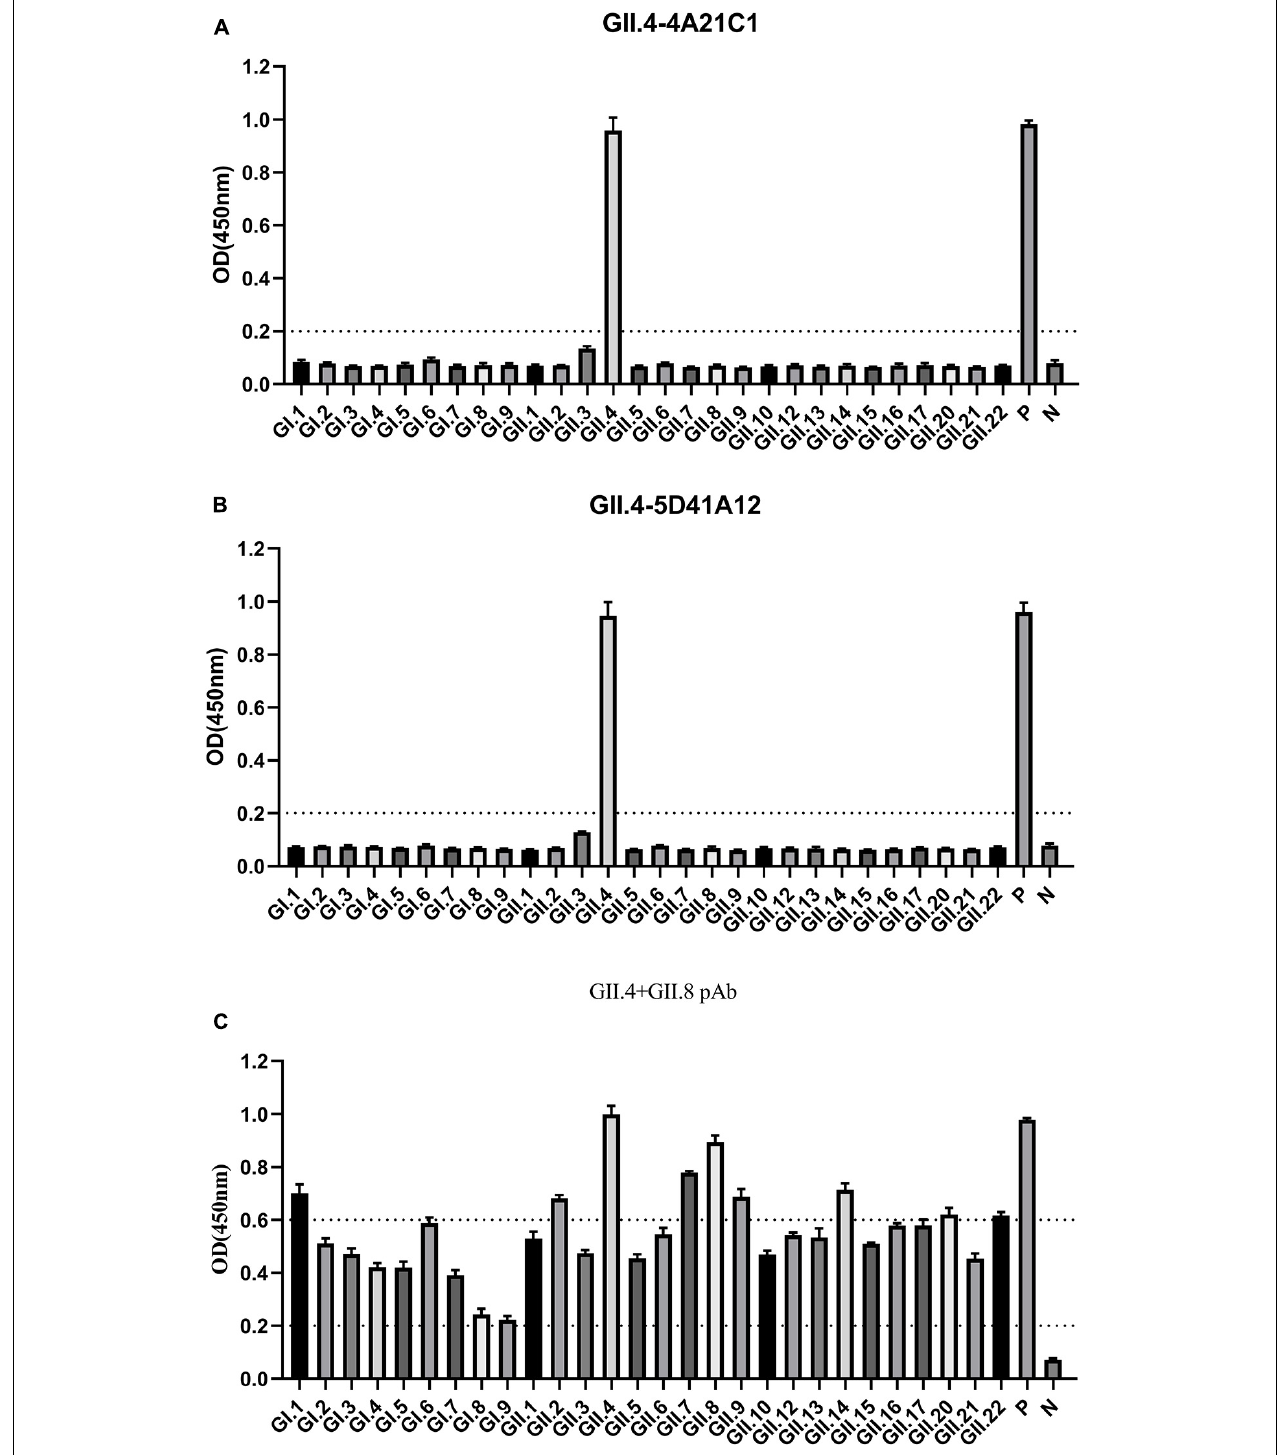
FIGURE 3 | Characterization the broad spectrum of antibodies. 9 GI and 19 GII P proteins were used as antigens with enzyme-linked immunosorbent assay (ELISA), reacting with GII.4-4A21C1 (A) , GII.4-5D41A12 (B) mAbs, and GII.4 + GII.8 pAbs (C) , and each protein was coated with three wells. The horizontal line at 0.2 illustrates the cut-off value for samples that are considered positive. 0.2–0.6 OD is considered a moderate binding. OD > 0.6 represents robust binding. P, positive control; N, negative control.